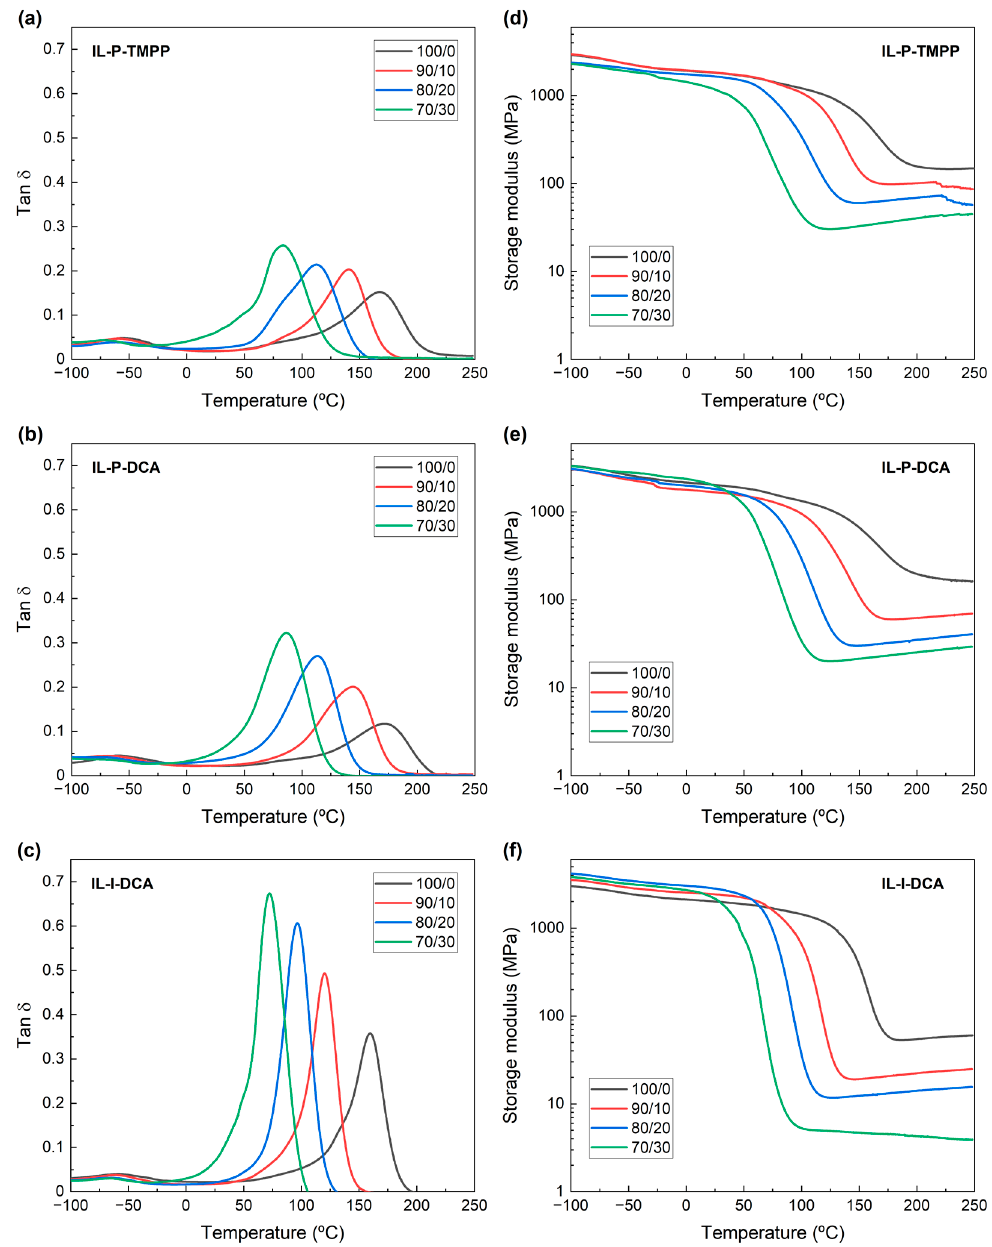
Figure 2. Tan δ ( a ) IL-P-TMPP, ( b ) IL-P-DCA and ( c ) IL-I-DCA) and storage modulus ( d ) IL-P-TMPP, ( e ) IL-P-DCA and ( f ) IL-I-DCA) vs. T curves obtained by DMA for the DGEBA/PCL blends at different PCL contents. Table 4. T g and crosslinking densities obtained from the DMA analysis.